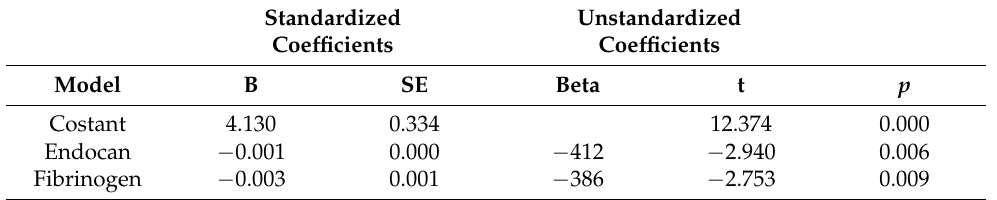
Table 4. Multivariable regression model.